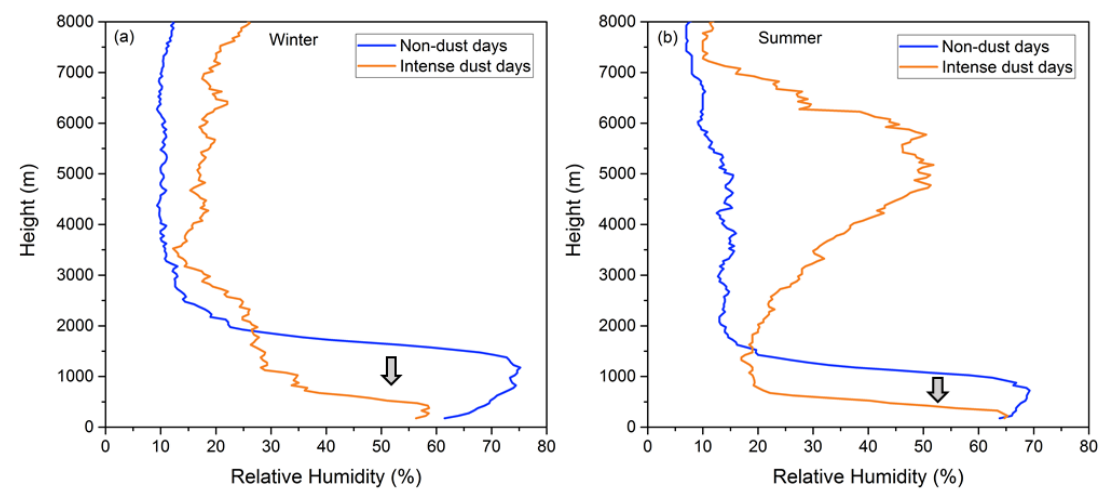
Figure 6. Vertical profiles of median relative humidity (%) from radiosonde observations for non-dust days and intense-dust days shown for ( a ) winter dust outbreaks (December–March) and ( b ) summer dust outbreaks (July–August), 2012 to